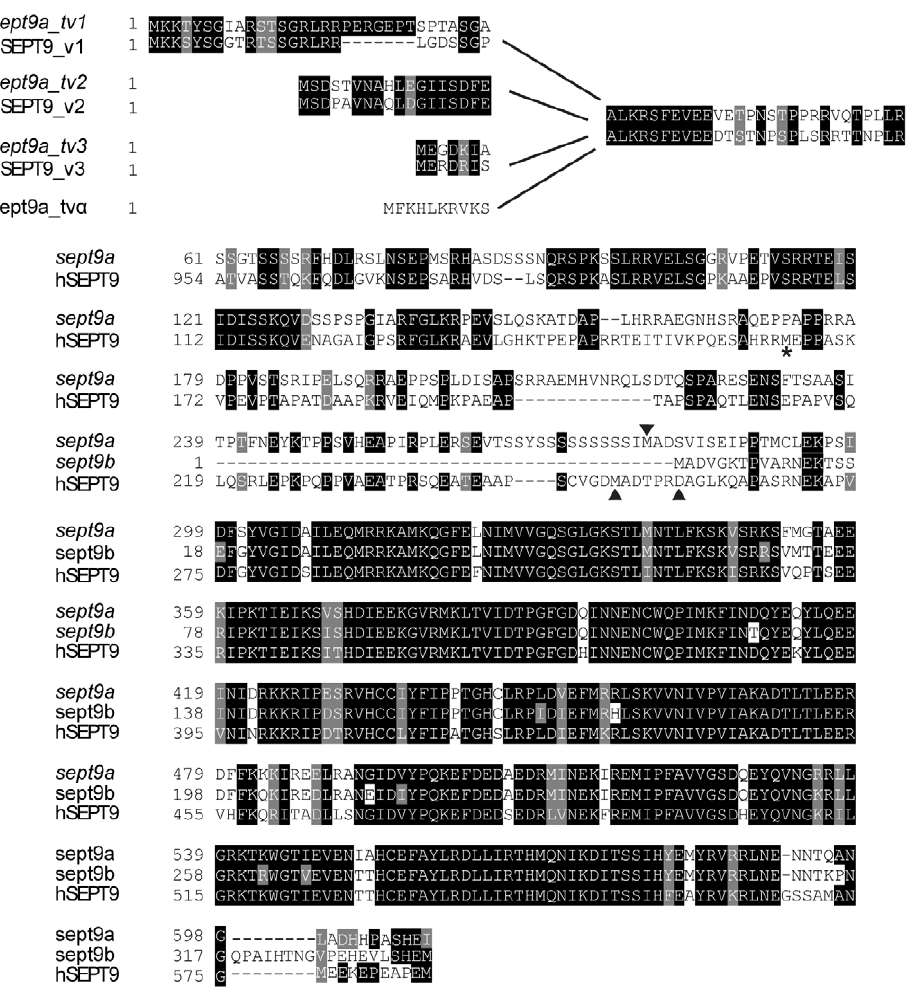
Figure 2. SEPT9 amino acid sequence is conserved between zebrafish and mammals. Amino-acid alignments of zebrafish Sept9a and Sept9b putative protein products show a high degree of conservation. An asterisk notes the starting methionine of human SEPT9_i5/6, which is not conserved in zebrafish. Arrowheads mark the starting methionines for human Sept9_v7, and zebrafish isoforms Sept9a_tv7 and Sept9b (both transcripts).